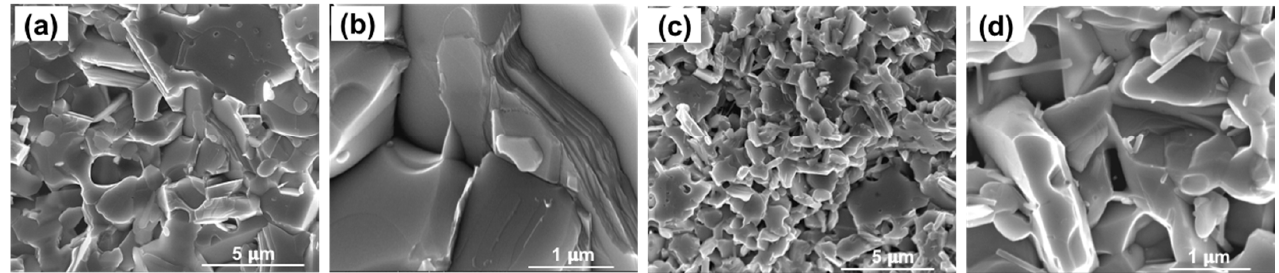
Figure 6. SEM micrographs of SPS sintered Bi 2 Te 3 pellets at different magnifications for materials synthesized through MW-assisted hydrothermal ( a , b ) and polyol ( c , d ) routes.